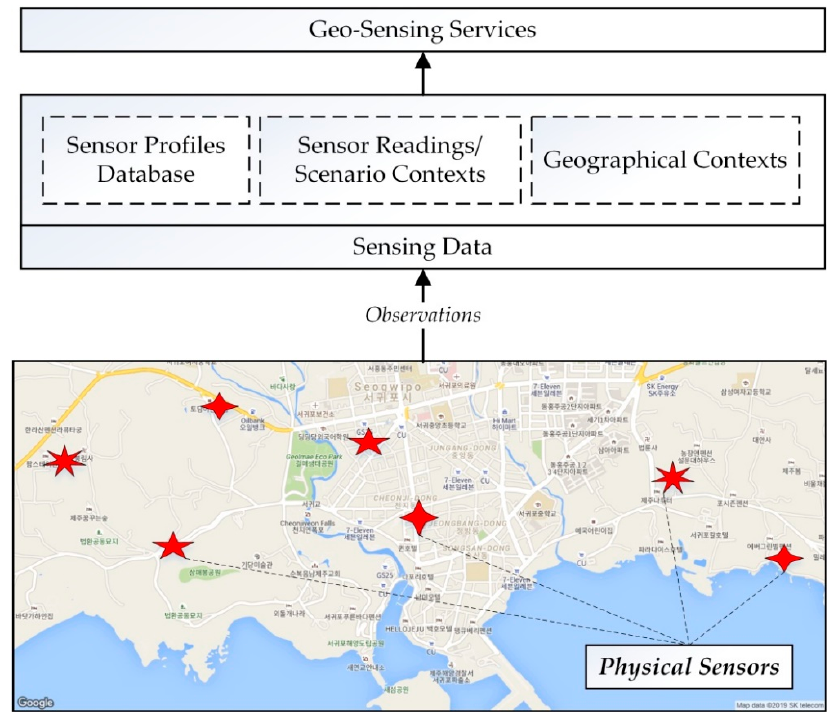
Figure 1. Conceptual overview of geo-sensor networks and services.